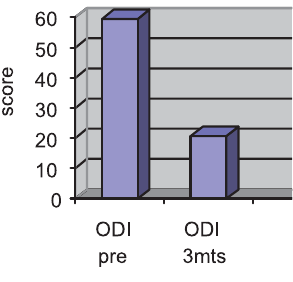
FIGURE 1. Preoperative (left) and postoperative (right) lateral roentgenograms. (Lateral roent- genograms after implantation of interspinous device shows sepa- ration of the posterior elements with accompanying unloading of the facet joints, widening the intervertebral foramen and thus decompressing the vertebral ca- nal and relieving the load on the disc).